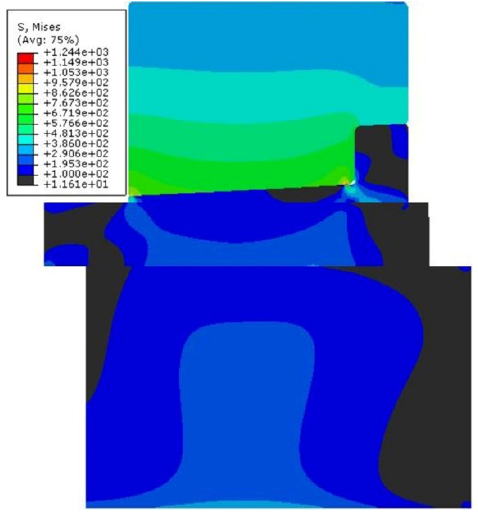
Figure 5. The distribution of Von Mises stress of the turbine shrink disk using the ideal model.